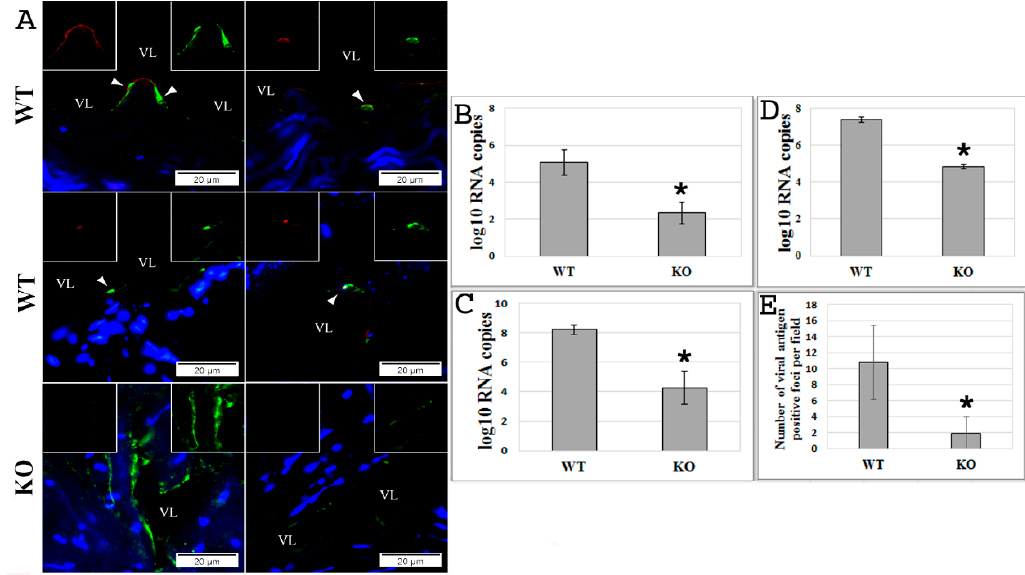
Figure 1. Absence of the exchange protein directly activated by cAMP 1 ( EPAC1 ) gene attenuates Ebola virus (EBOV) infection ex vivo and in vitro. ( A ) Representative dual-target immunofluorescence (IF) staining of EBOV (red) and endothelial cell (EC)-specific von Willebrand factor (vWF; green) in sections of ex vivo aortic ring vasculatures prepared from Epac1 -null (KO) and wild-type (WT) mice 72 h postinfection (p.i.) with EBOV. Nuclei of mouse cells were counterstained with DAPI (blue). Inserts depict split signals of EBOV (red) and vWF (green) from the colocalized areas (arrow heads). Scale bars, 20 µm. VL, vascular lumen. ( B ) The number of viral RNA copies detected in the media of ex vivo aortic ring vasculatures of KO and WT mice at 72 h p.i. with EBOV. N = 3 for each group. ( C , D ) The number of viral RNA copies detected in brain microvascular endothelial cells (BMECs) ( C ) and media ( D ) at 72 h p.i. with EBOV at an MOI of 0.5. N = 3 for each group. ( E ) The number of viral antigen-positive foci measured using IF microscopy in the monolayers of BMECs, which were isolated from KO and WT mice, at 72 h p.i. with EBOV at an MOI of 0.5. N = 30 for each group. * p < 0.005 compared with WT groups.